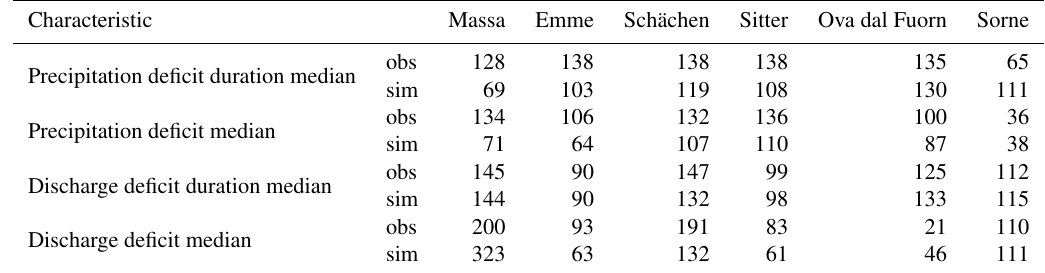
Table 1. Median of the observed (obs) and simulated (sim) distributions for precipitation deficit duration, precipitation deficit, discharge deficit duration, and discharge deficit for the catchments Massa–Blatten, Emme–Eggiwil, Schächen–Bürglen, Sitter–Appenzell, Ova dal Fuorn–Zernez, and